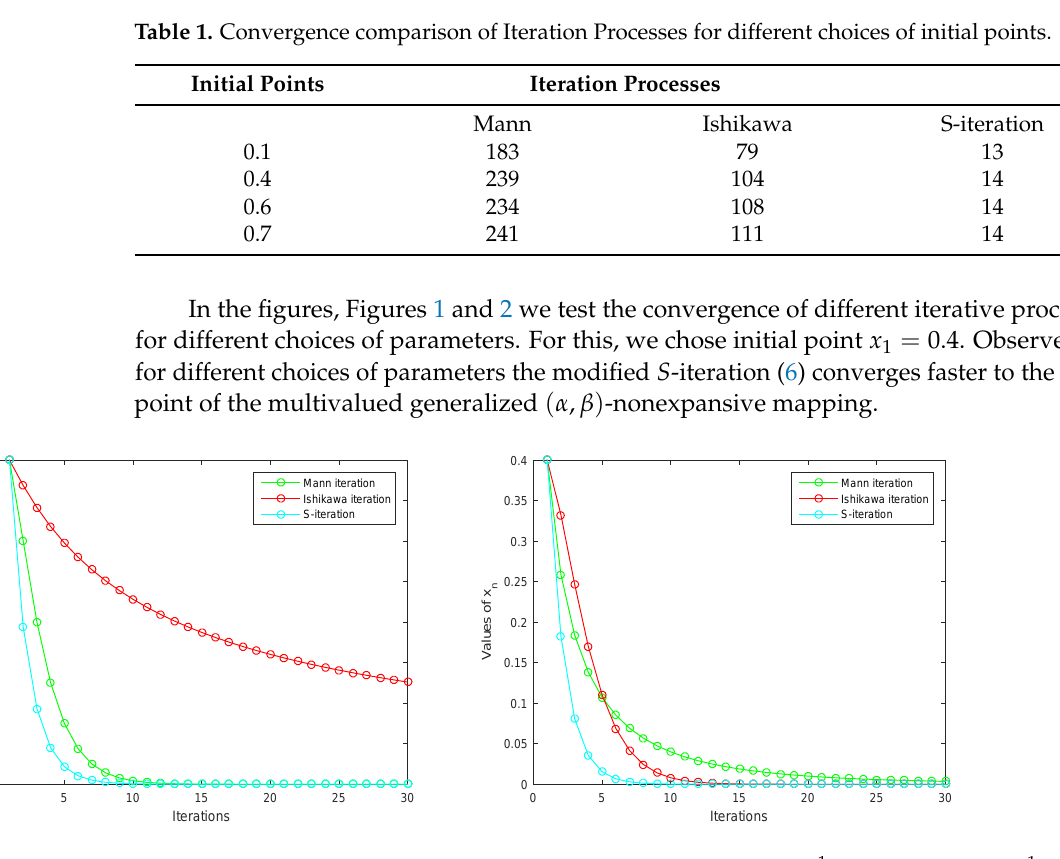
, β n = 1 (left plot), α n = 1 √ n + 7 n + 1